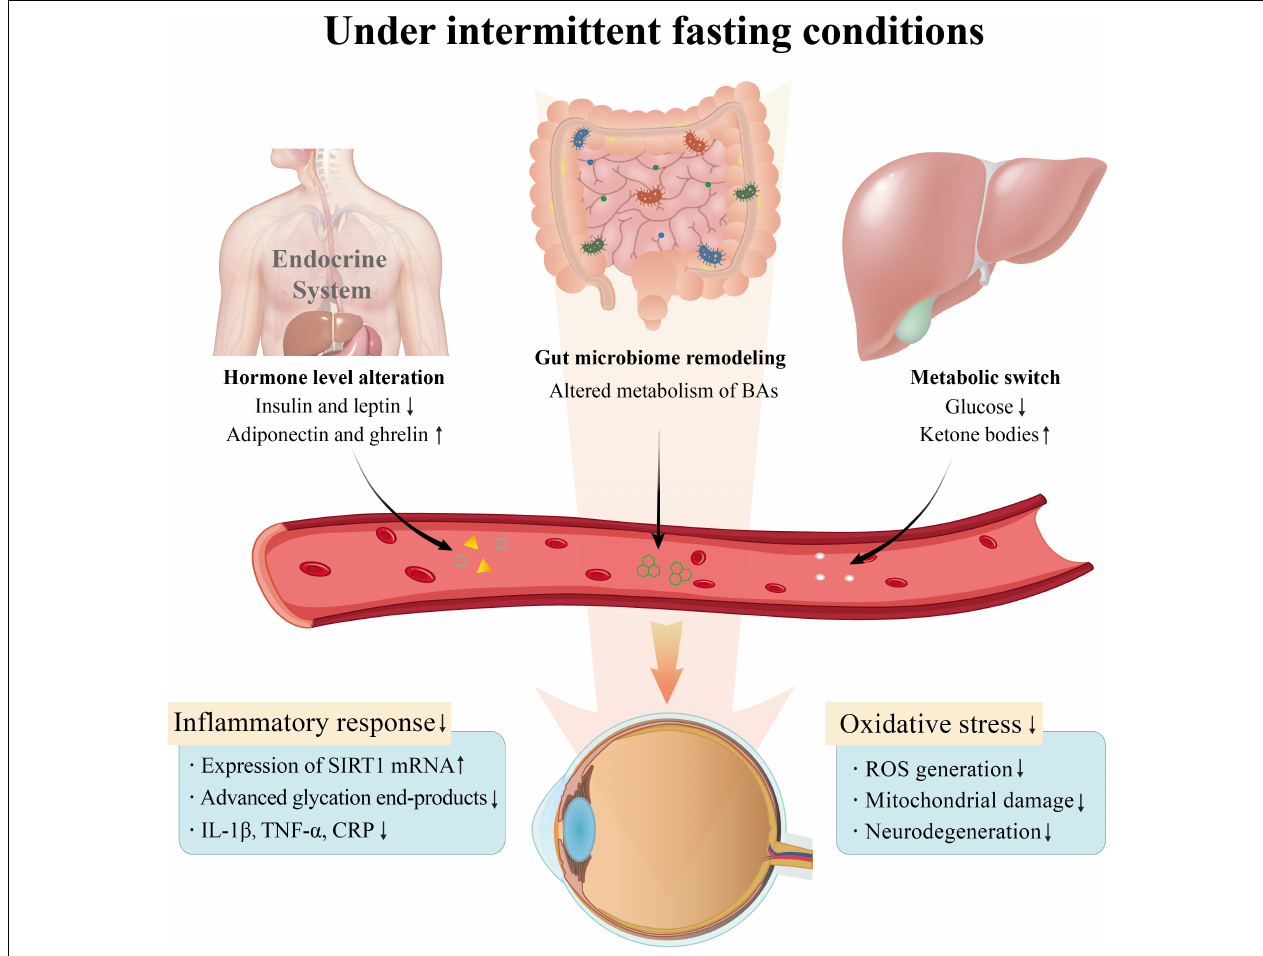
FIGURE 4 | Effect of body metabolism on the eye under intermittent